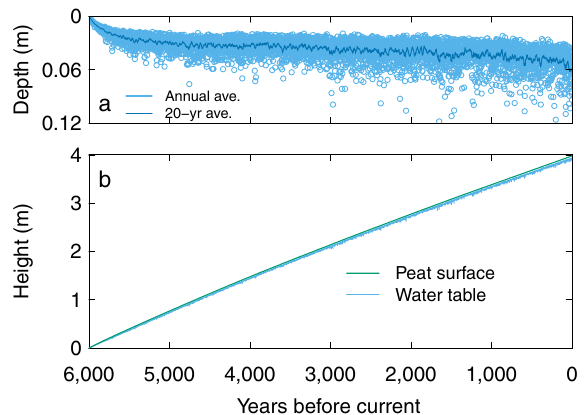
Figure 4. Development of the virtual blanket peatland over six millennia. ( a ) Water-table depth and ( b ) the peat surface from the virtual core at the centre of the peatland from the baseline simulation (see the main text and